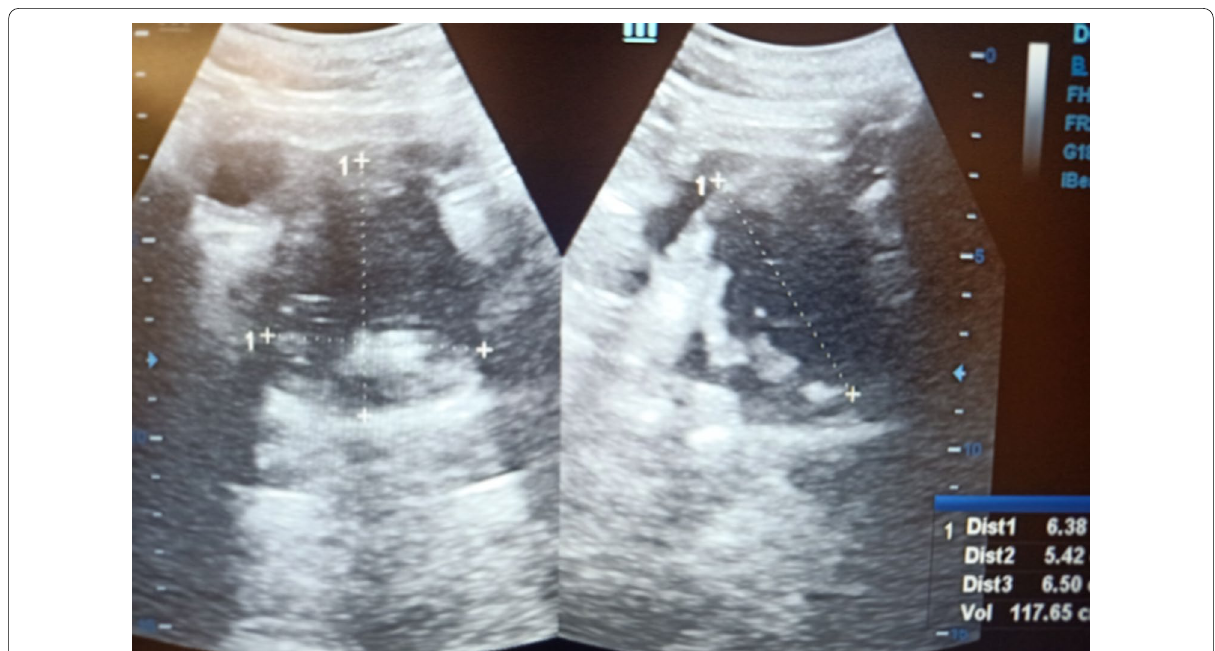
Fig. 7 Ultrasound image for prostate volume pre‑embolization showing, prostate of estimated volume